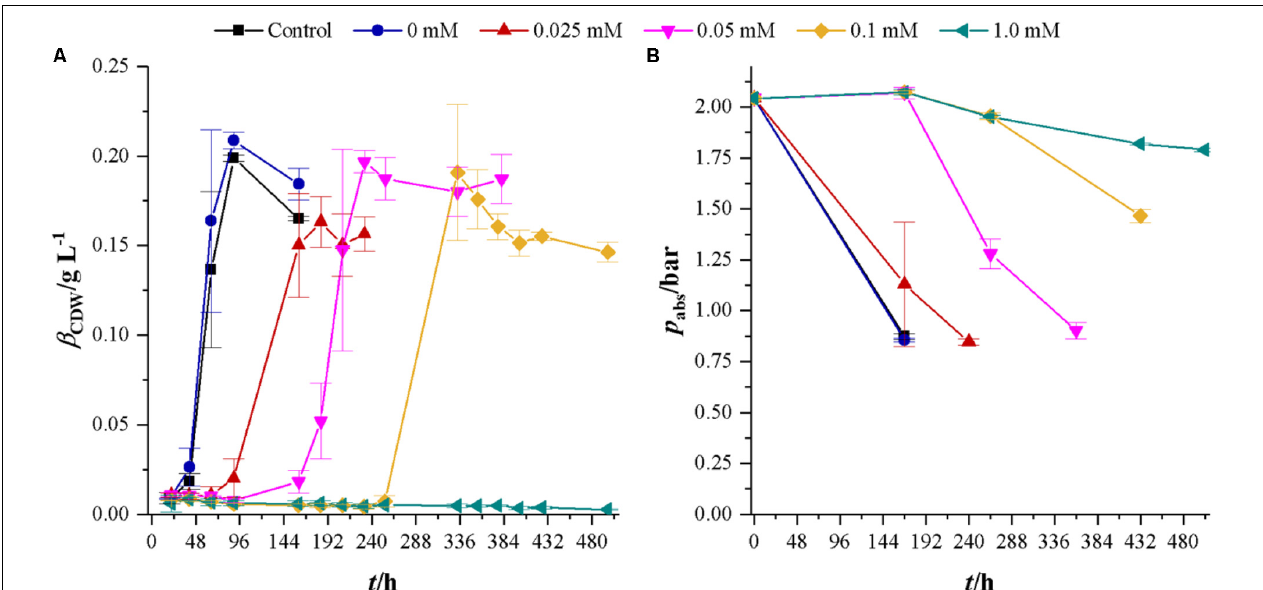
FIGURE 4 | Development of CDW and headspace pressure of cultivations of C. ljungdahlii in the presence of different cyanide concentrations with syngas as a carbon and energy source. Each value is an average of three cultivations. Control cultures (black squares) do not contain any phosphate buffer or cyanide while cultures with 0 mM cyanide (blue dots) contain 1 mL of 100 mM potassium phosphate buffer at pH 11. Other cyanide concentrations are 0.025 (red triangles), 0.05 (magenta upturned triangles), 0.1 (yellow diamonds), and 1.0 mM (petrol tilted triangles). (A) CDW and (B) mass concentration of fructose. Average values of three independent